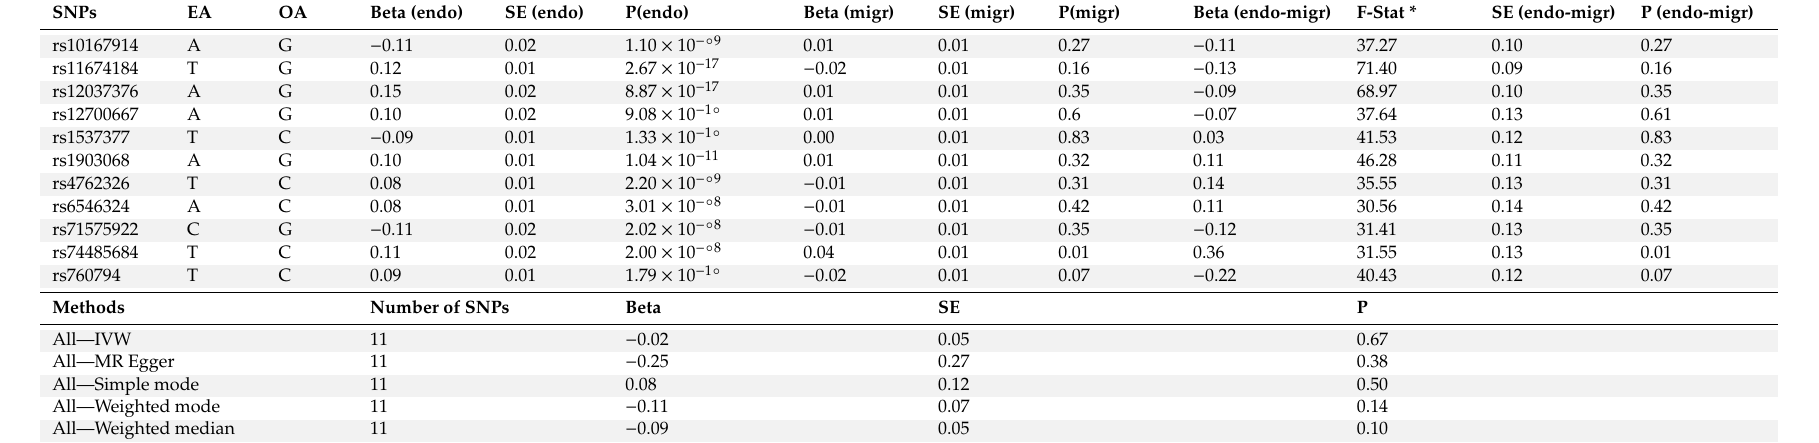
Table 3. Instrumental variables, Mendelian randomisation (MR) results and sensitivity